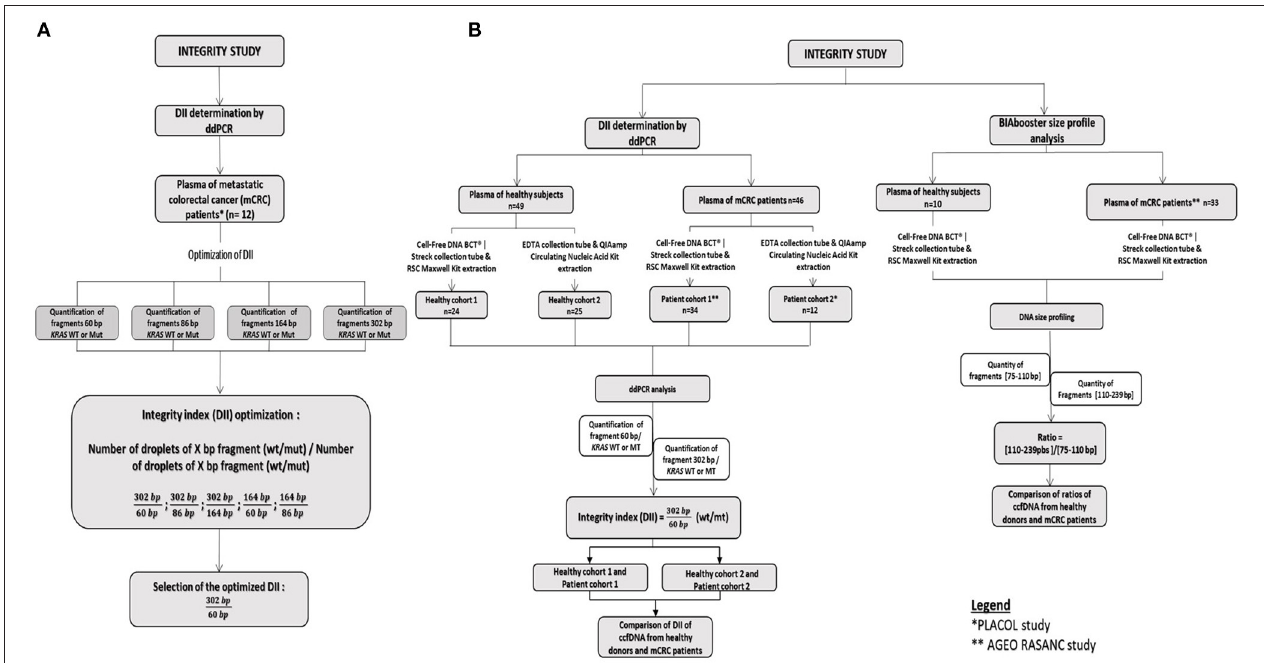
FIGURE 1 | Workflow of the integrity study. (A) Development of the DII using the PLACOL cohort ( n = 11 samples analyzed). DNA hasbeen quantified using, respectively, 60, 86, 164, and 302 bp amplicons. Several combinations have been tested to determine the optimal DNA integrity index. Finally, the 302/60 bp ratio turned out to be the most clinically relevant. (B) Samples from two prospective cohorts of patients presenting a mCRC were included, AGEO RASANC ( n = 67) and PLACOL ( n = 12) cohort with a total of 81 metastatic CRC samples. Circulating cell-free DNA integrity of 34 patients (AGEO RASANC cohort) and 12 patients (PLACOL cohort) was analyzed by ddPCR, and ccfDNA size profiling of 33 patients (AGEO RASANC cohort) was analyzed by BIAbooster System. As the preanalytic conditions (blood collection tubes, plasma ccfDNA extraction kits) are different for these two prospective cohorts of patients, the corresponding control groups were included; 8.5ml blood per tube from 59 healthy subjects are used as negative controls and split into two groups (control groups A and B). Thirty-four healthy blood samples were collected in cell-free DNA BCT from Streck, and circulating DNA has been extracted with Maxwell RSC ccfDNA Plasma Kit from the plasma samples associated, and 25 blood tubes were sampled in EDTA tubes and circulating DNA purified by the QIAmp® Circulating Nucleic Acid Kit (Qiagen) from plasma samples associated. Among control A and B healthy subjects’ samples, DNA integrity of 49 plasma was analyzed by droplet-based digital PCR, and ccfDNA size profiling of 10 plasma was analyzed by BIAbooster